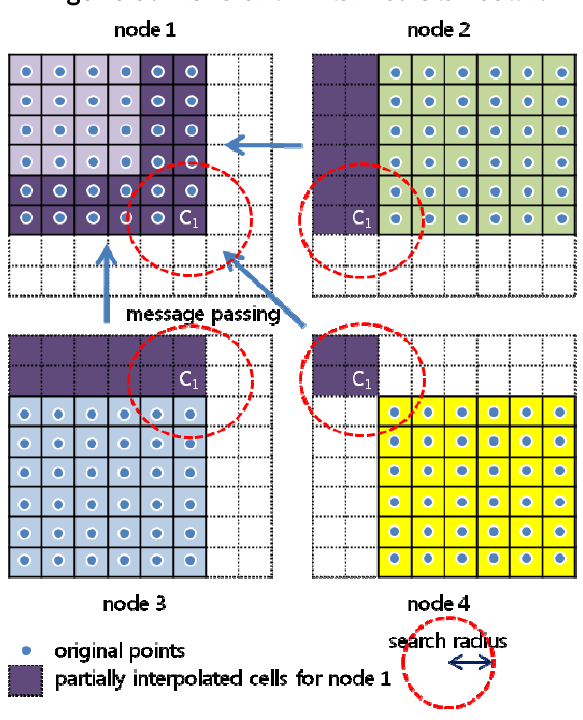
Figure 6. Transfer of intermediate